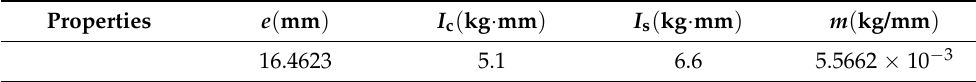
Table 4. Properties computed by analytical integrals.